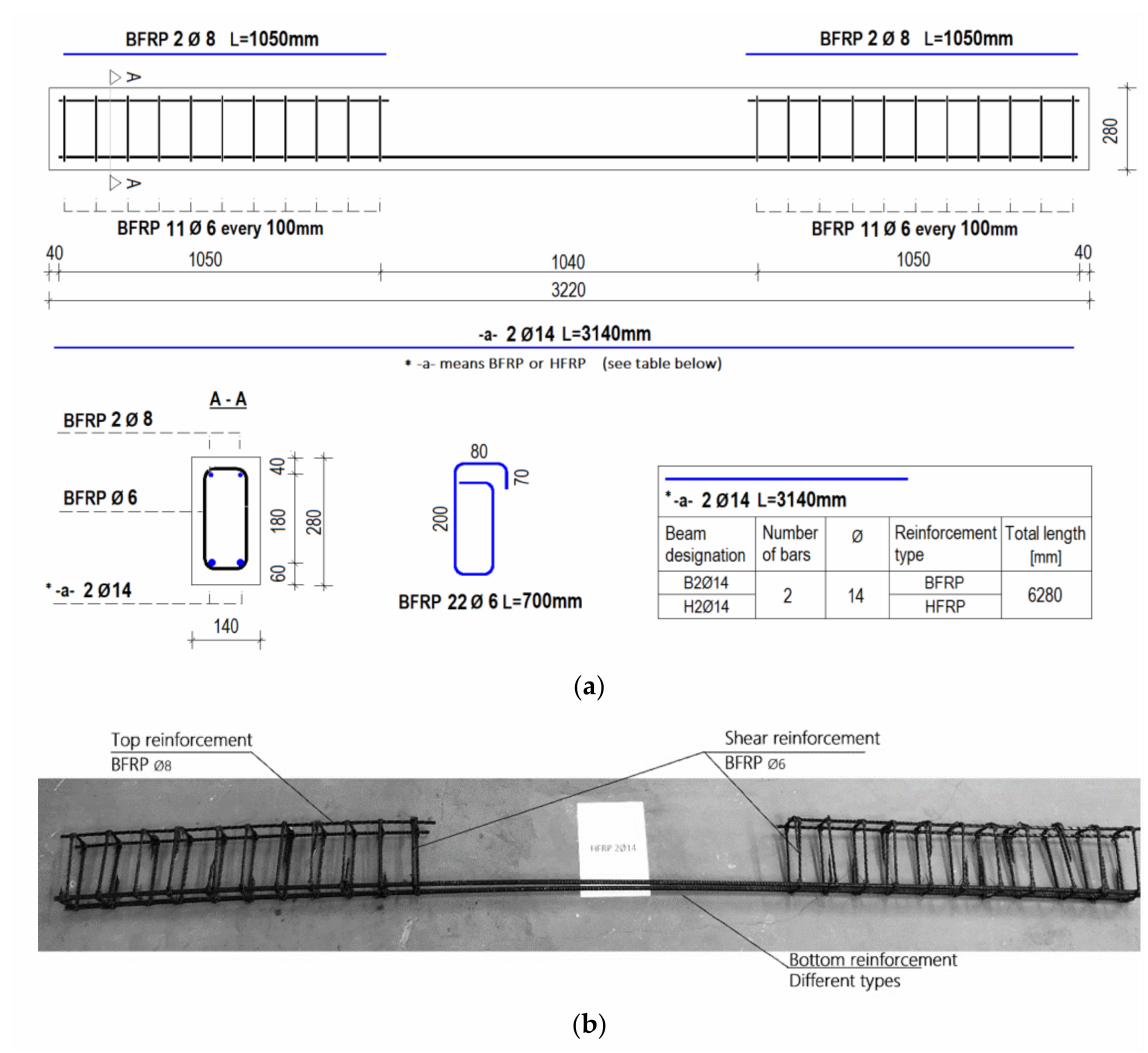
Figure 1. Reinforcement scheme of the tested specimens: ( a ) schematic details of different configura- tions; ( b ) example of reinforcement configuration (set 1.2.—sample